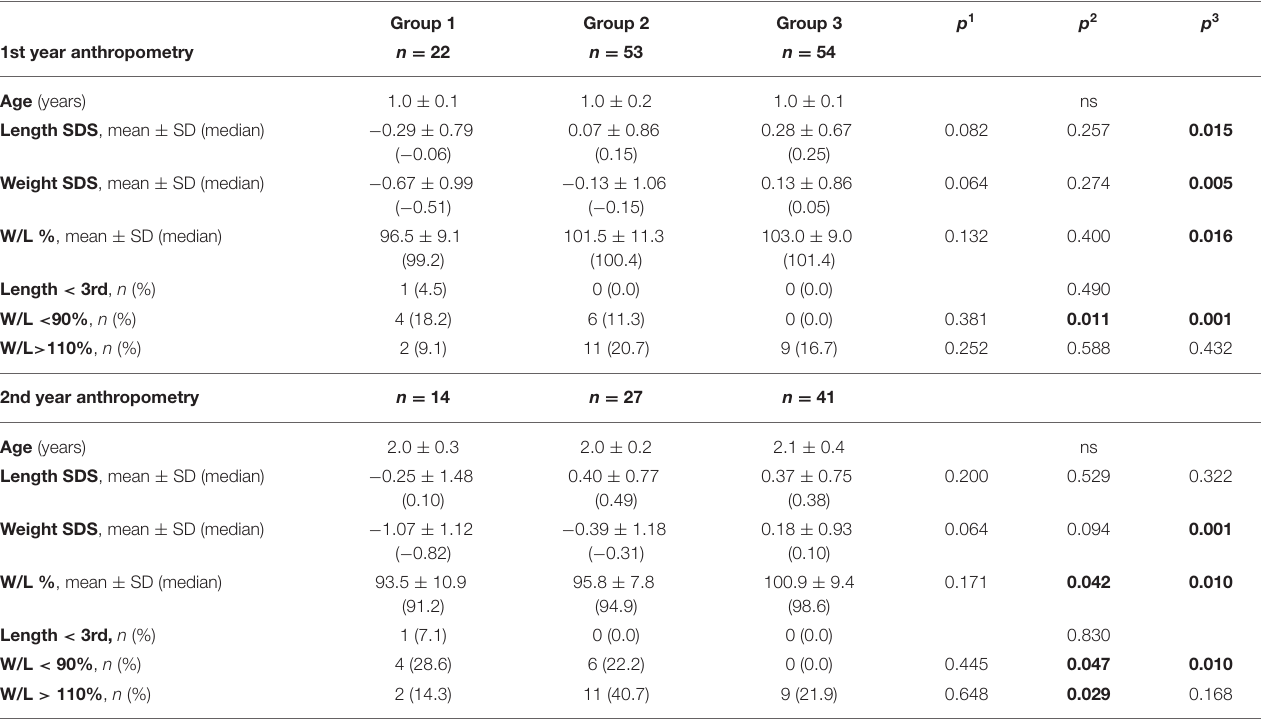
TABLE 3 | Anthropometric follow-up